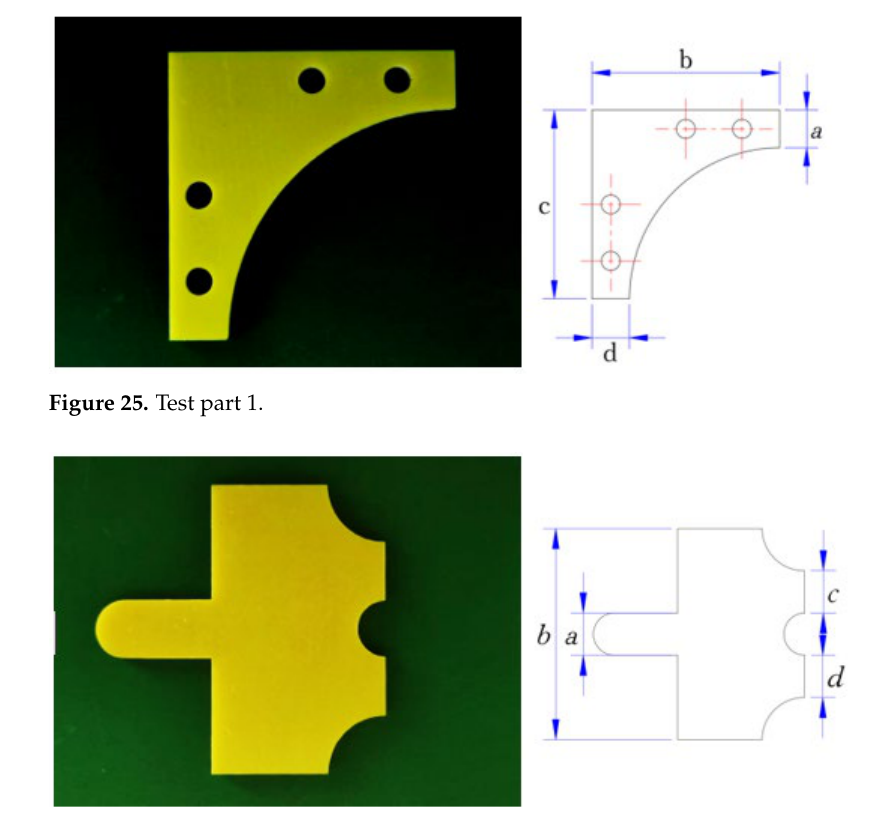
Figure 26. Test part 2. Table 6. Manual versus visual measurement.